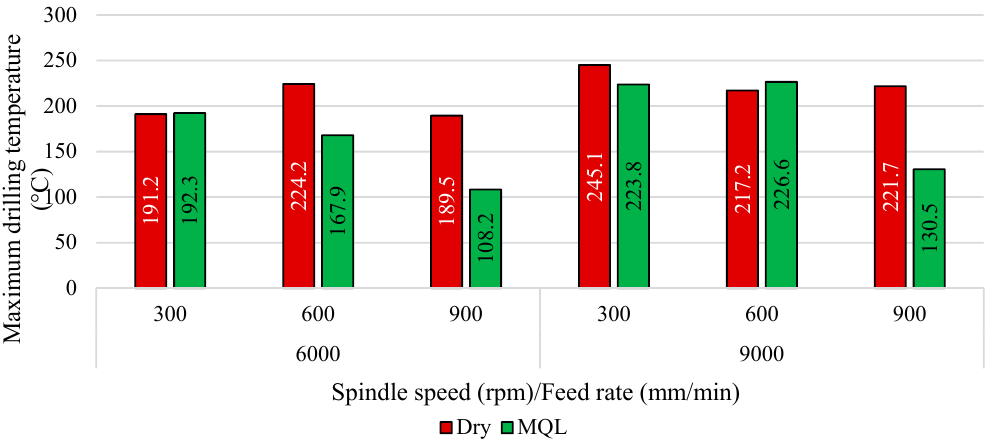
Figure 8. Comparison of the exit temperature of holes drilling under MQL and dry conditions.